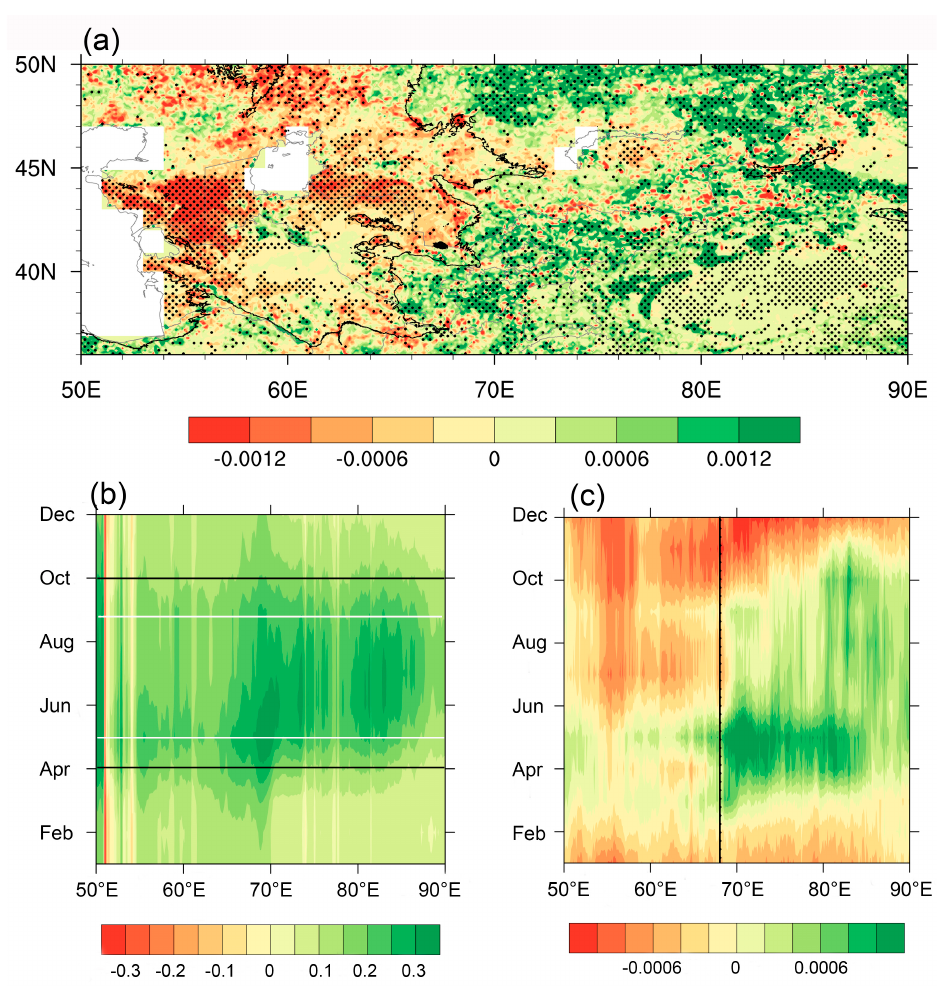
Figure 2. ( a ): Spatial distribution of growing season NDVI trends in ACA from 1982 to 2015. The solid black curve is the boundary at an elevation of 300 m, its west side is the area with an elevation lower than 300 m and the east side is the area with an elevation higher than 300 m. The black dots are areas that passed the significance test ( p < 0.05); ( b ): cross-sectional plots of monthly distributions of the average value of NDVI, with the white lines showing May and September and the black lines showing April and October; ( c ): cross-sections of monthly vegetation trends, with the black line in the range of 65°E to 70°E.